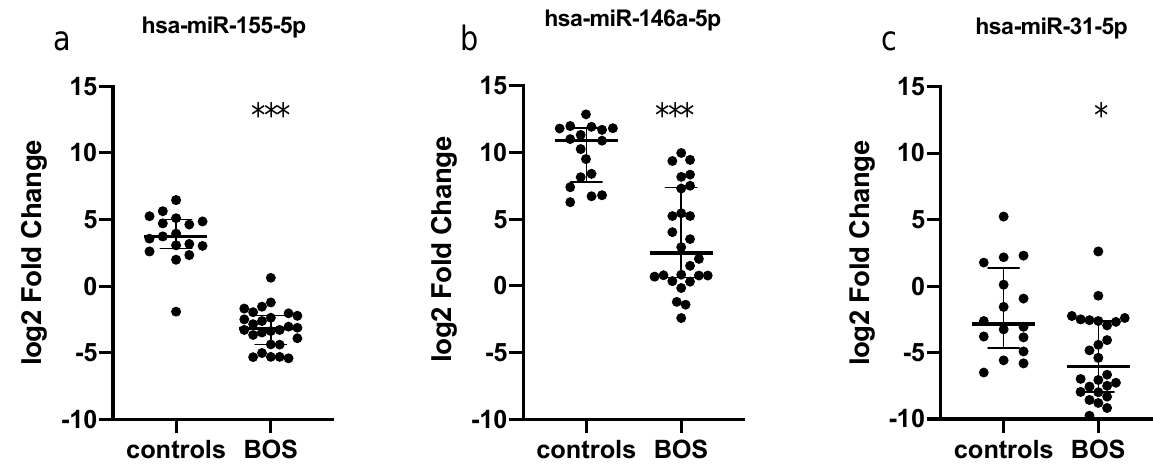
Figure 1. Quantitative expression of ( a ) miR-155, ( b ) miR-146a and ( c ) miR-31 in serum samples from 26 patients before ECP therapy and 17 healthy subjects. Relative expressions were expressed as log2 transformed values. *** p < 0.0001; * p < 0.05.